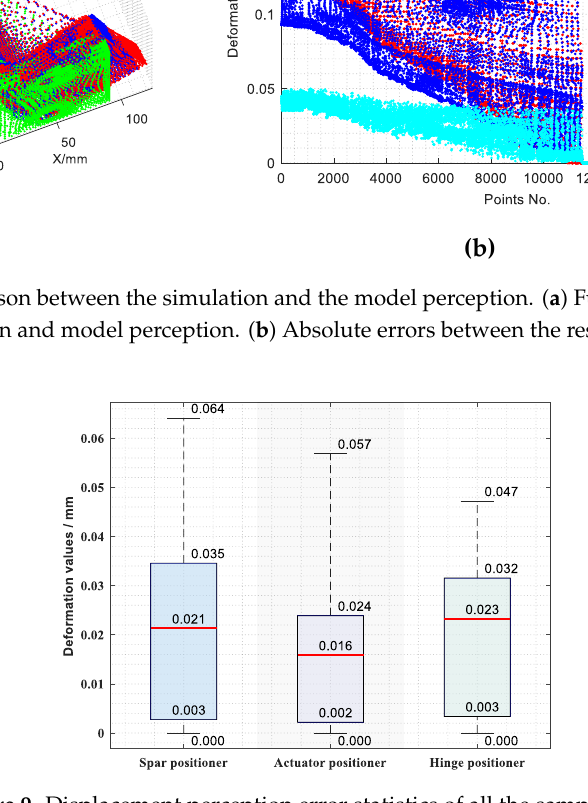
Figure 9. Displacement perception error statistics of all the samples in S 2 .